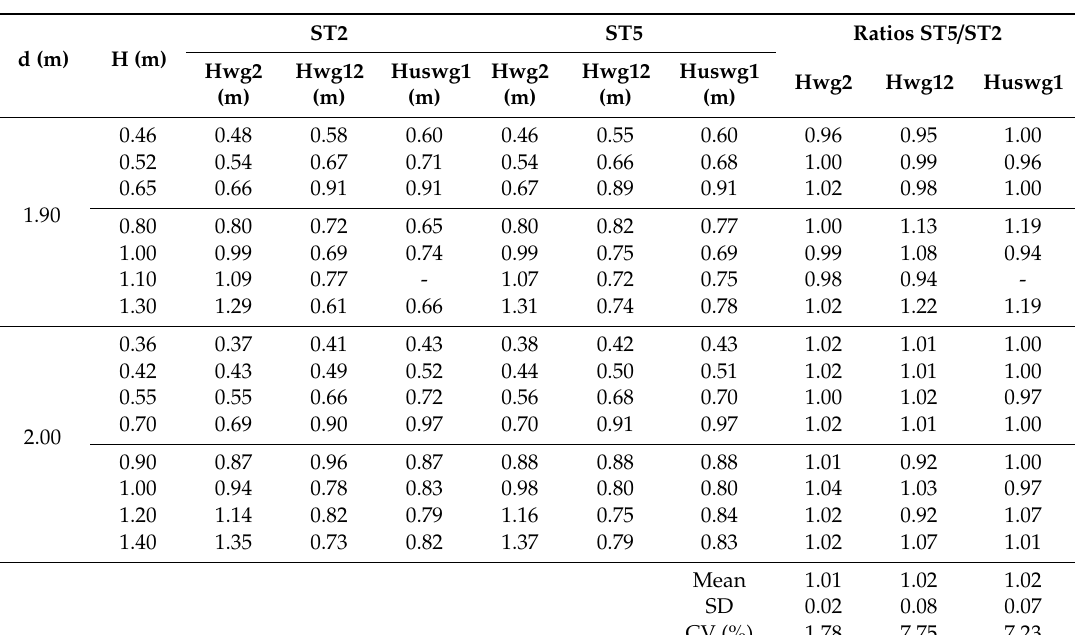
Table 2. Measured wave heights at three wave